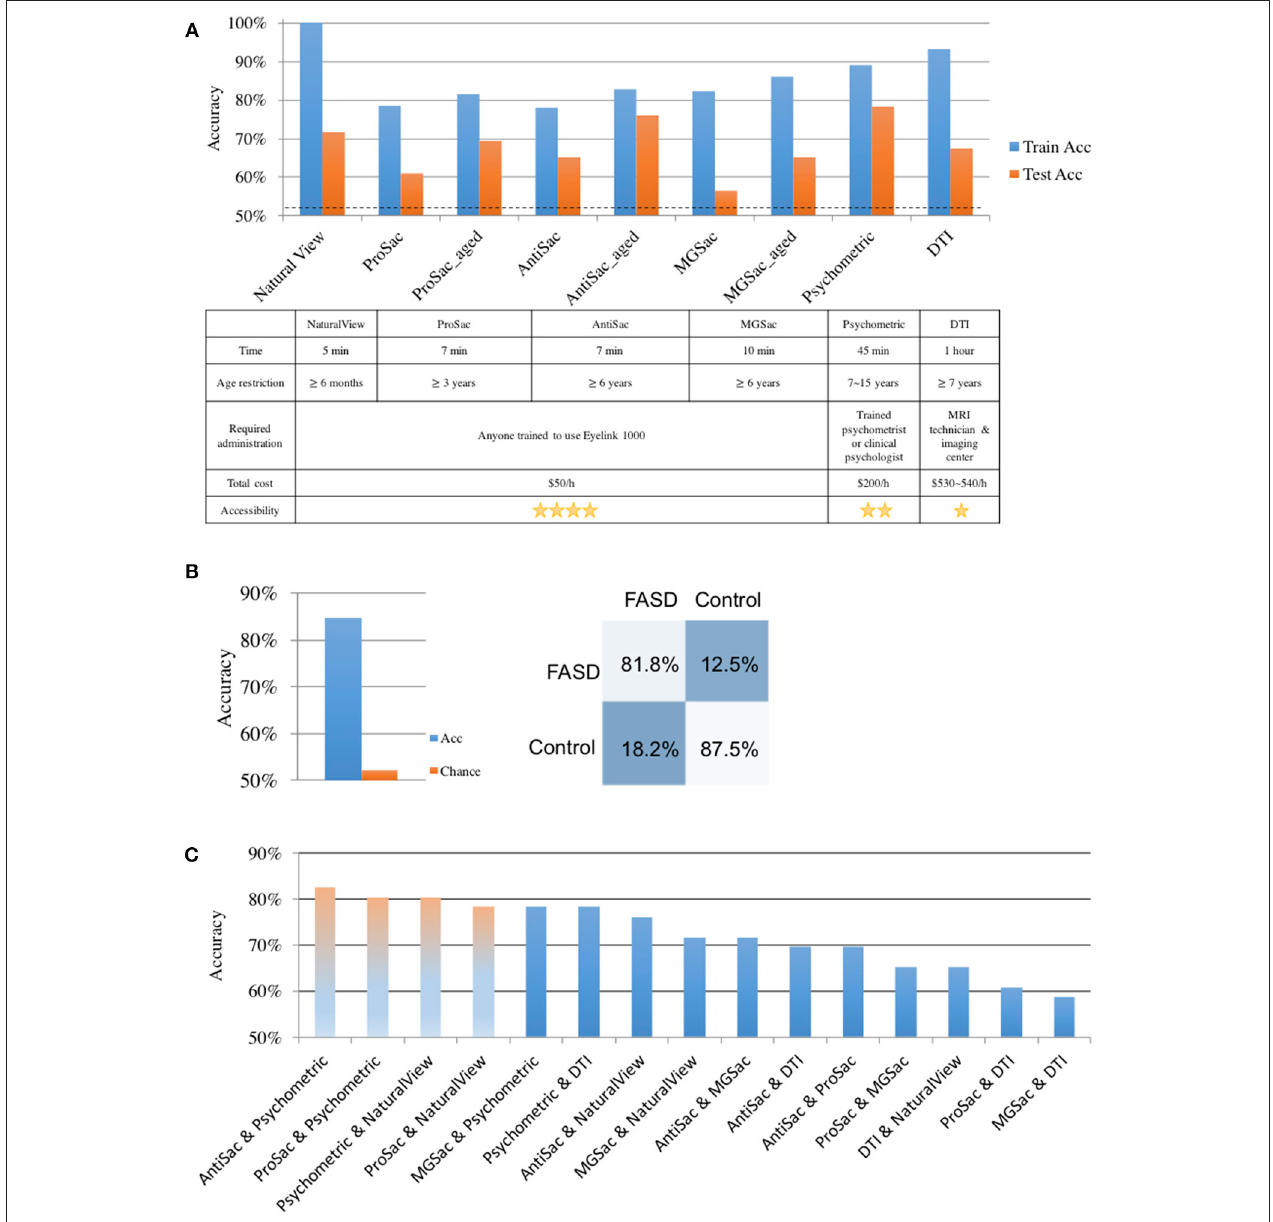
FIGURE 2 | Classification results. (A) Classification accuracies and evaluations on single assessments. Top: train (cross validation) and test accuracies of each assessment. Bottom: evaluations of different assessments. (B) Classification accuracy on all assessments. Left: classification accuracy and the chance level. Right: the confusion matrix. (C) Classification results of pairwise assessments. The first three light-colored bars show accuracies of the top pairs. The forth shows the highest accuracy without psychometric